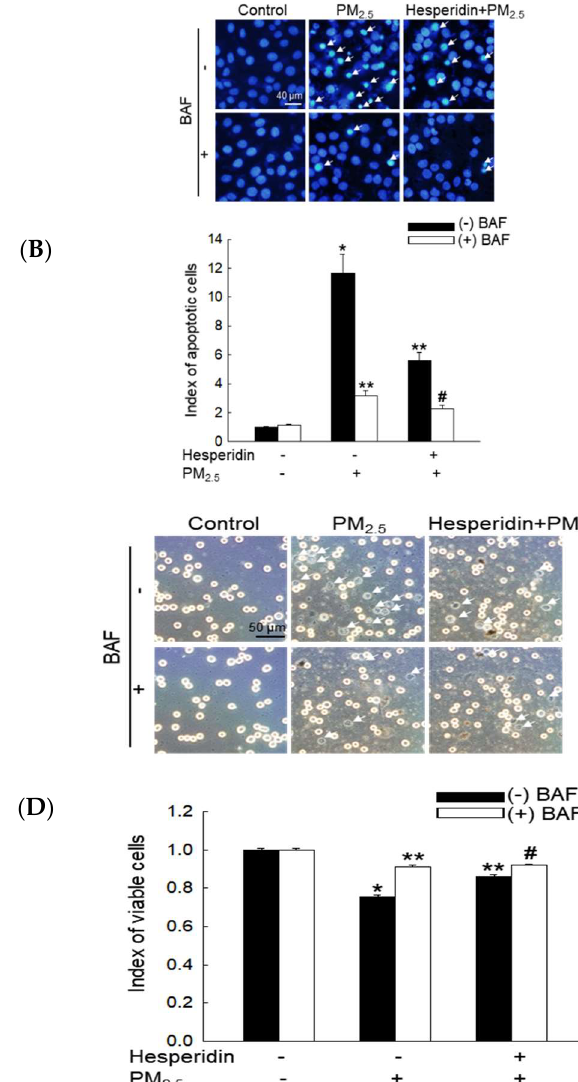
Figure 4. Hesperidin prevented cellular apoptosis and reduced cell viability via the inhibition of PM 2.5 -induced autophagy. Cells were pretreated with hesperidin (50 µM), BAF (10 nM), or both for 1 h, and then exposed to PM 2.5 (50 µg/mL) for another 24 h. ( A ) Autophagy was detected using images captured via fluorescence microscopy after staining with acridine orange. ( B ) Apoptotic bodies were observed using Hoechst 33342 staining, and the arrows indicate apoptotic bodies. Cell viability was assessed via ( C ) MTT assay and ( D ) trypan blue staining, and the arrows indicate the dead cells. * p < 0.05, ** p < 0.05, and # p < 0.05 compared with BAF-untreated control cells, BAF- untreated PM 2.5 -exposed cells, and BAF-untreated hesperidin + PM 2.5 -exposed cells, respectively.